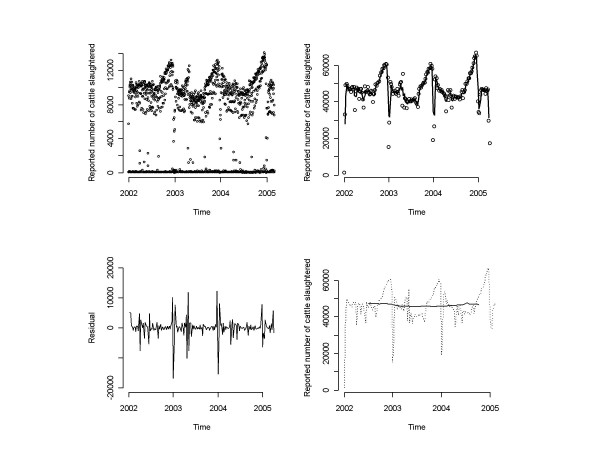
Time series for cattle slaughter reported to BCMS over the period 1st Jan 2002 and 28th Feb 2005. (a) Raw data plotted at daily intervals (b) 3-point moving average (raw weekly data shown as unconnected symbols) (c) Residuals after accounting for the 3-point moving average (d) 53-point moving average (raw weekly data shown as unconnected symbols).